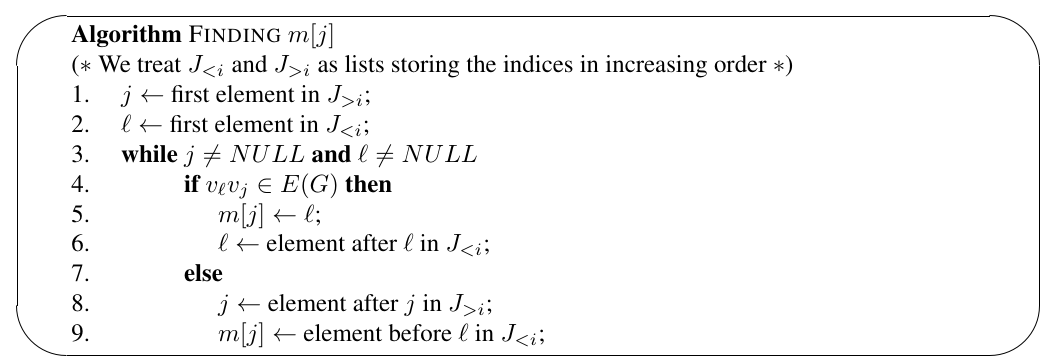
Figure 5: Algorithm used in the proof of Lemma